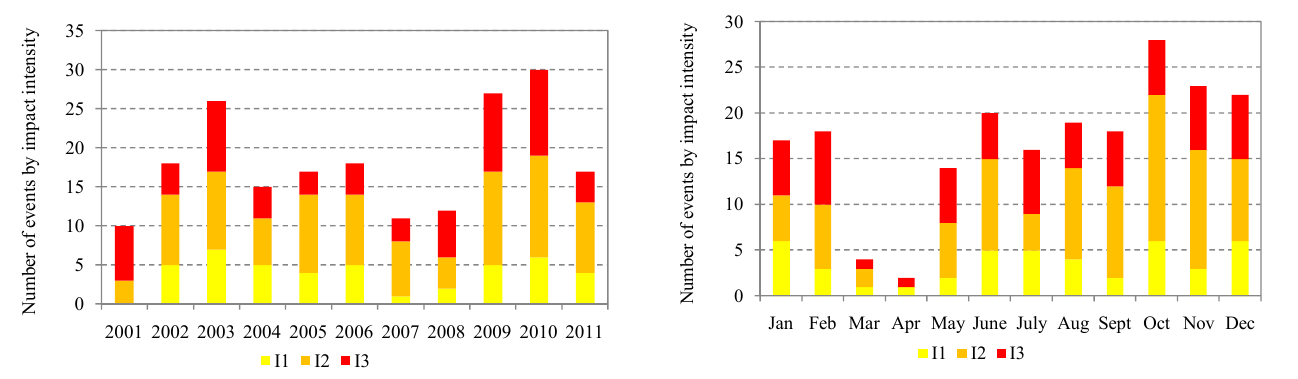
Fig. 2. Annual distribution of high-impact weather events by impact intensity, for the period 2001–2011.